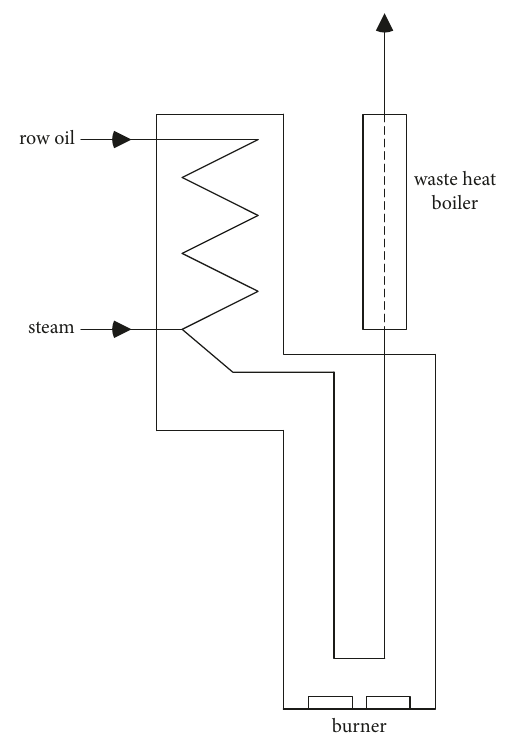
Figure 1: Schematic diagram of the structure of a cracking